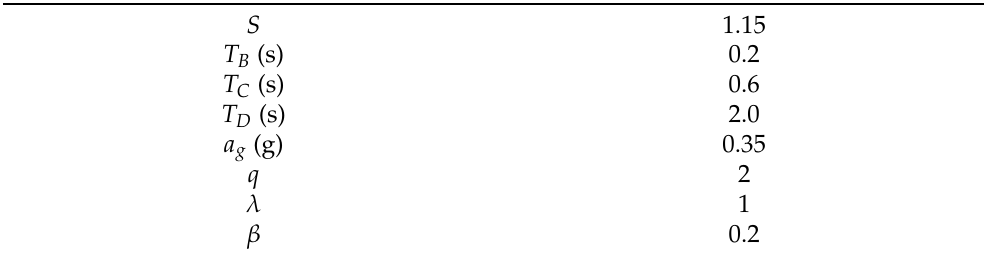
Table 1. Properties of the considered site in Tehran, Iran. Data adapted from the design spectrum in